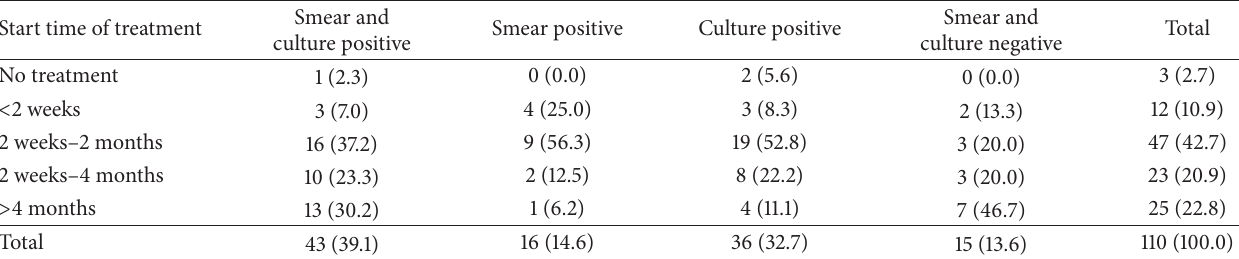
Table 4: Distribution of defaulters by time of default and bacteriological